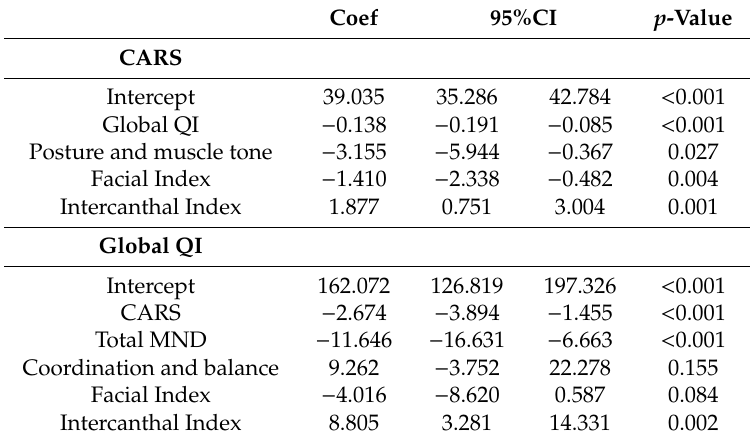
Table 5. Standard linear regression analyses on CARS and Global QI as dependent variables.